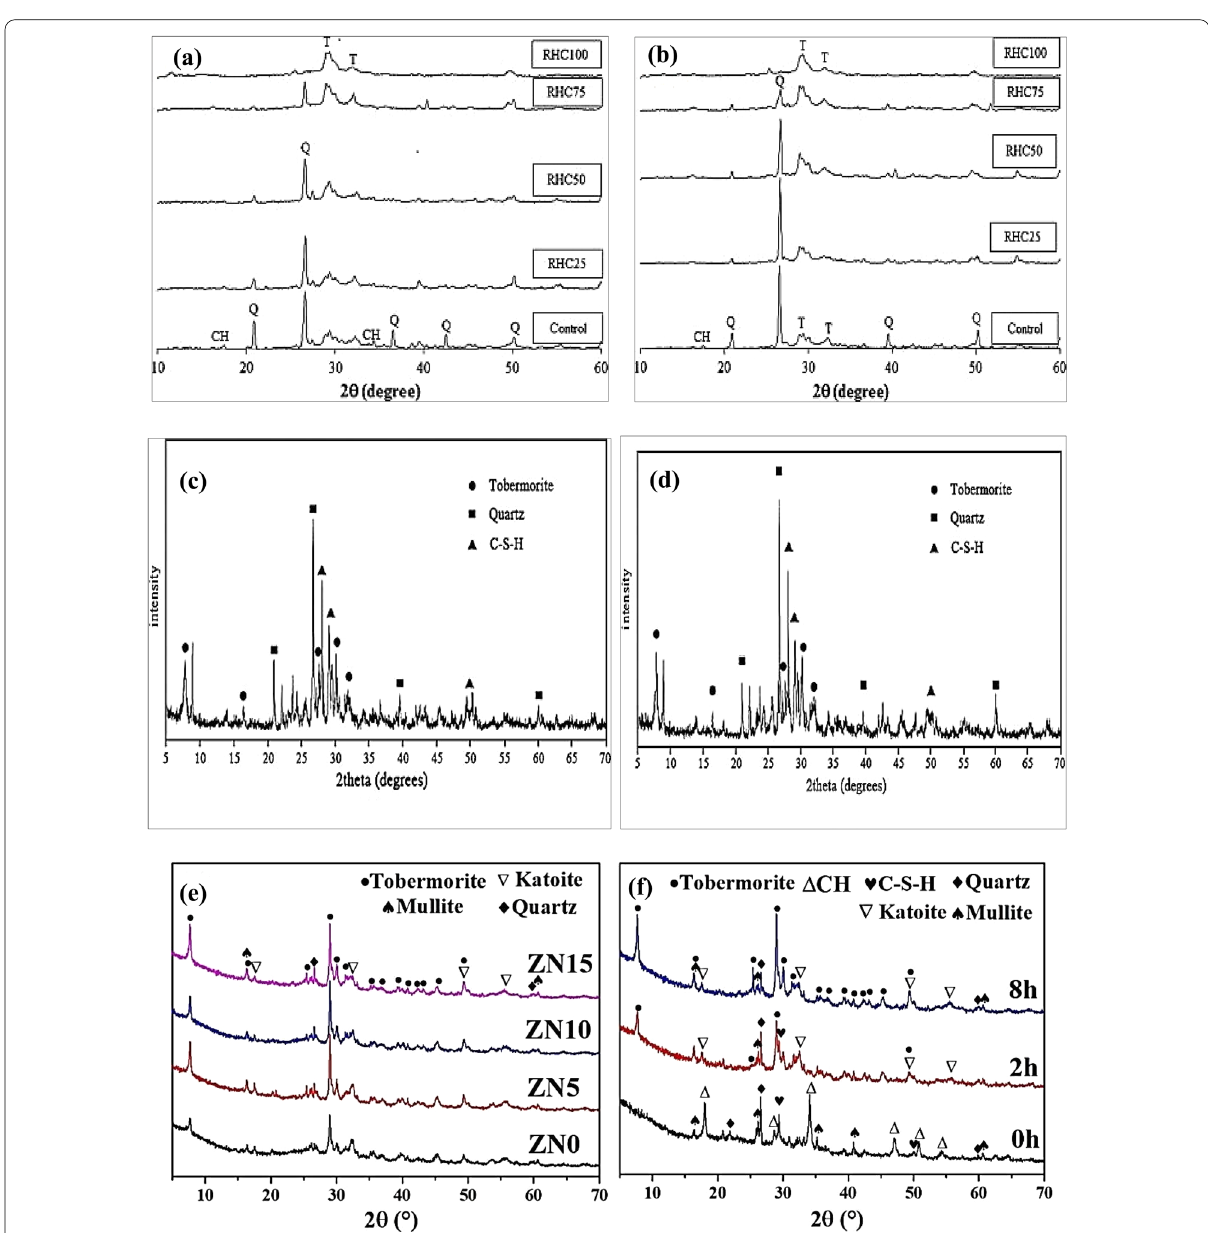
Fig. 12 XRD patterns of rice husk ash AAC samples: a at 8 h of autoclaving time and b 18 h of autoclaving time (Kunchariyakun et al., 2015). XRD curves of c normal AAC sample and d stone sawing mud AAC sample (Wan et al., 2018). XRD patterns of AAC e at different percentage of ZSM-5 waste and f 15% ZSM-5 AAC sample at different autoclaving time (Jiang et al.,